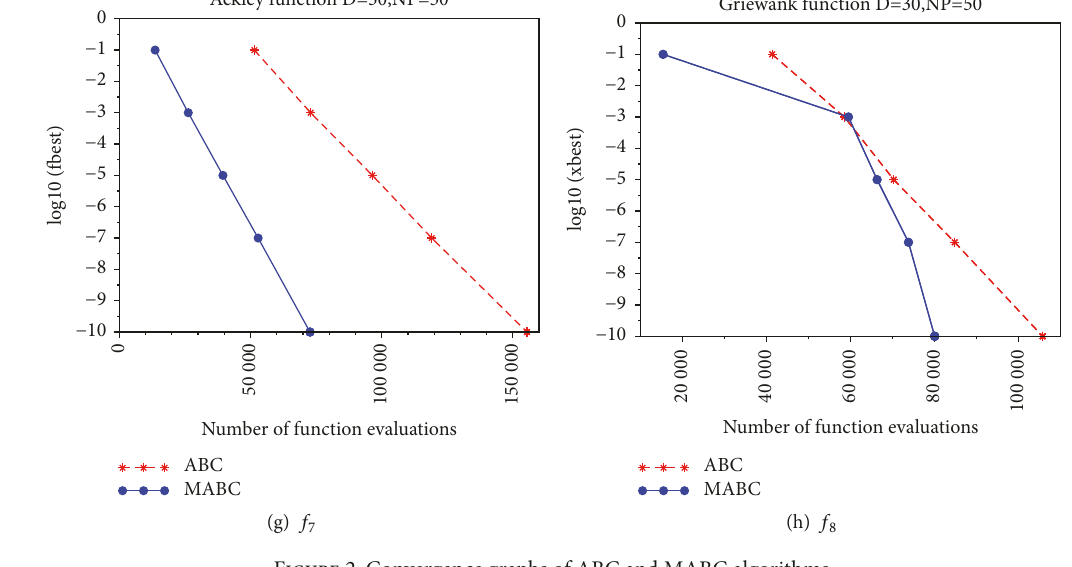
Figure 2: Convergence graphs of ABC and MABC algorithms.